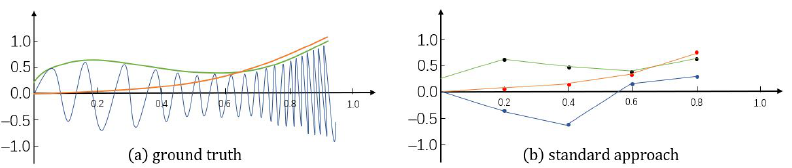
Figure 1. Low-frequency phase and amplitude samples for water height computing. The blue line represents the sea surface height of the original high-frequency waveform, the green line represents the amplitude value of the original wave, and the red line represents the phase value of the origi- nal wave. The amplitude and phase values of high-frequency waves can change slowly ( a ), and the result of height interpolation calculation is quite different from that of the original waveform ( b